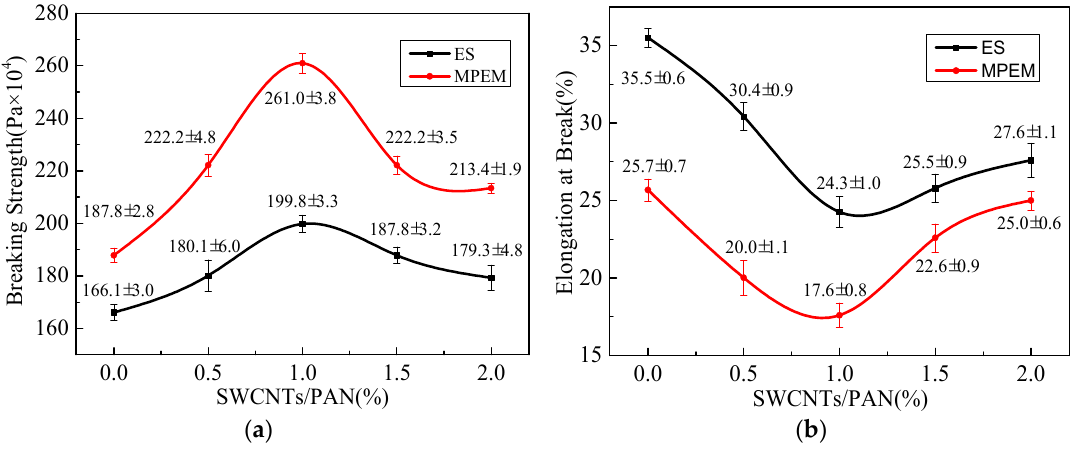
Figure 8. Mechanical properties of random and aligned SWCNTs/PAN nanofiber membranes with the different contents of SWCNTs. ( a ) Tensile strength (MPa); ( b ) elongation at break (%).